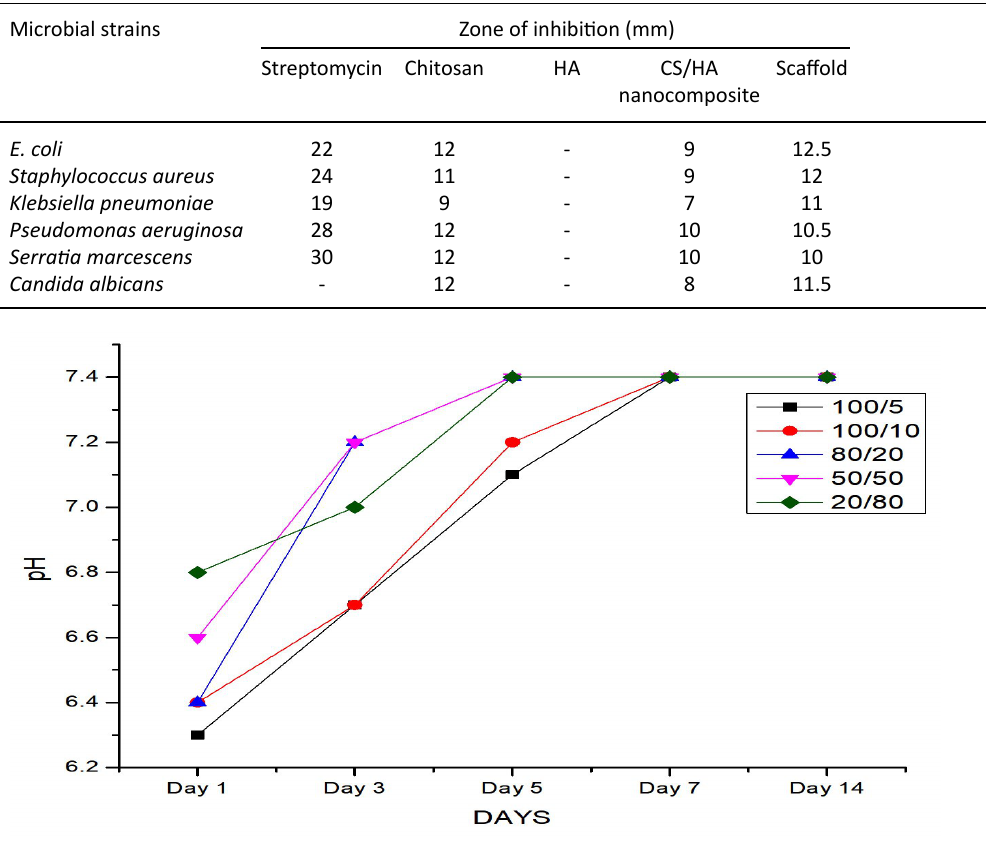
Fig. 3. Trend of fluctuation of pH value of the scaffold at different days: The pH value of the scaffold placed in the physiological solution was 6.4 on the 1st day. pH value increased gradually and reached at 7.4 on 5th day which is similar to the pH of human plasma (7.4)